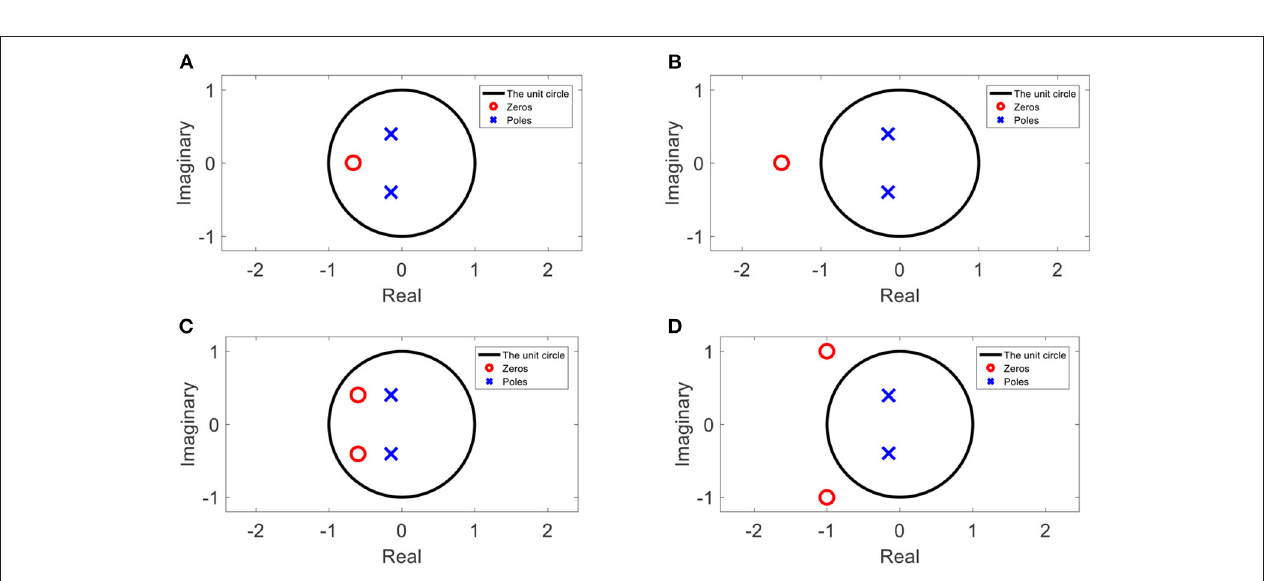
FIGURE 5 | An example of inverse zeros with or without imaginary components. (A) A zero inside the unit circle, (B) the inverse proportion of the zero from (A) , (C) a pair of zeros inside the unit circle, and (D) the inverse proportion of the pair of zeros from (C)